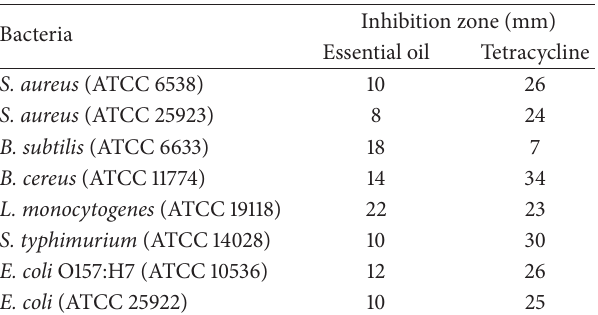
Table 3: Antibacterial effect of M. spicata essential oil by agar disk diffusion